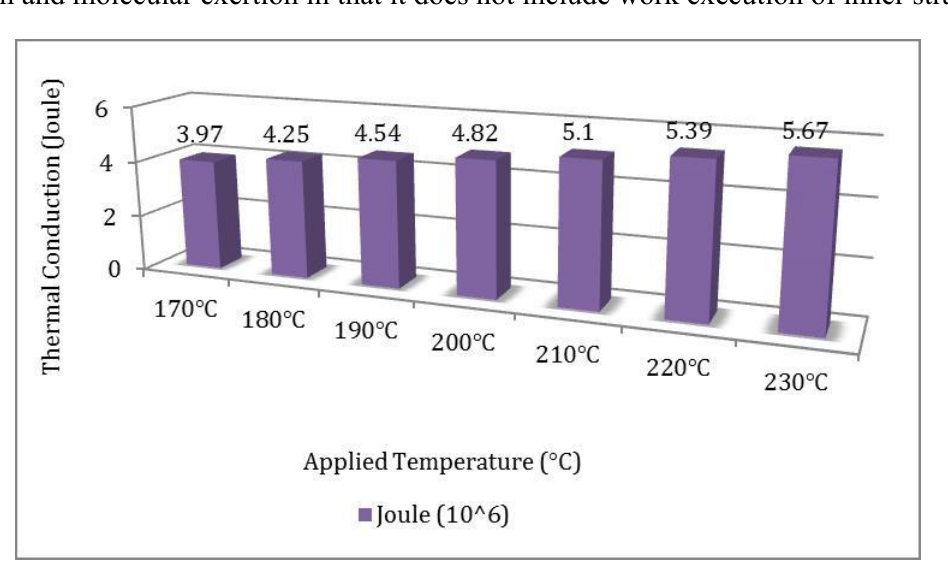
Fig. 4. Fabric’s thermal conduction values (J) at different temperature